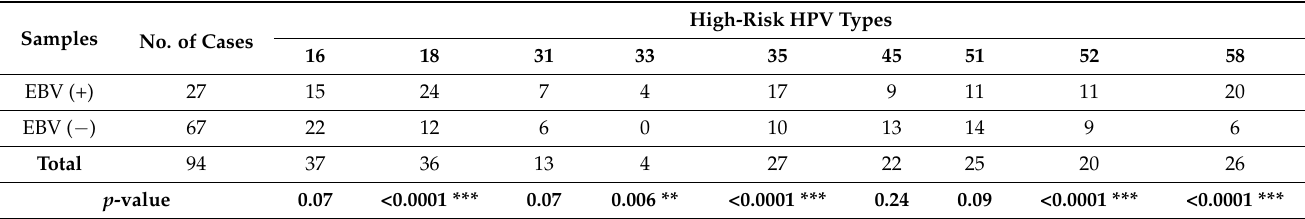
Table 2. Correlation of EBV and HPV-subtypes in Lebanese colorectal cancer